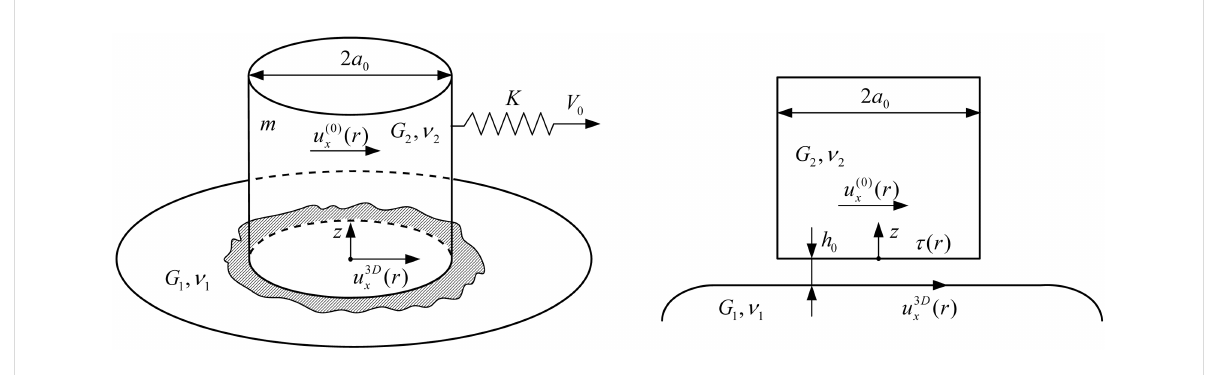
Figure 1: Geometrical scheme of the system under investigation. Stamp of a cylindrical shape with radius a 0 , made of material with shear modulus of G 2 and Poisson ratio v 2 , placed over the material with elastic parameters G 1 , v 1 . Upper and lower friction blocks are separated by a layer of lubricant with thickness h 0